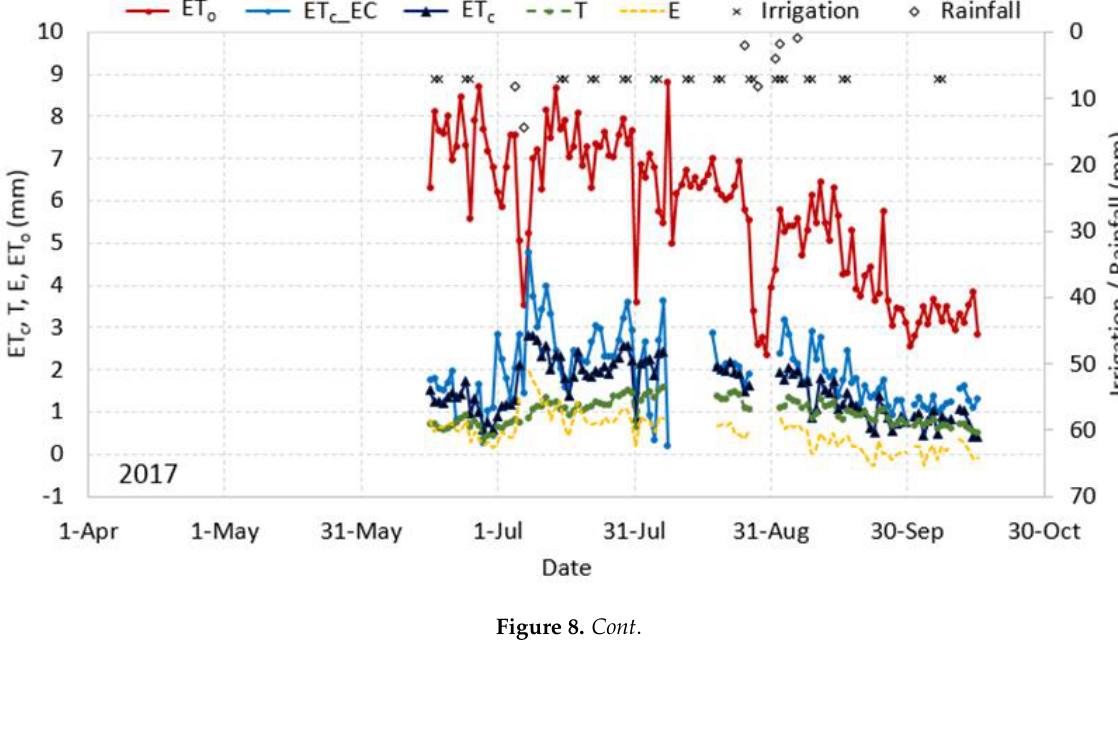
Table 4. Summary of the statistics for some assessments of the two-source energy balance scheme combined with radio- metric surface temperatures, reported in the literature over different croplands, using eddy-covariance (LE) or weighing lysimeter measurements (Hourly and Daily ET c ) as a basis.